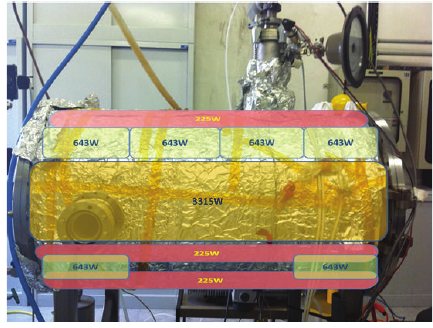
Figure 8: Position and powers of electrical resistances.